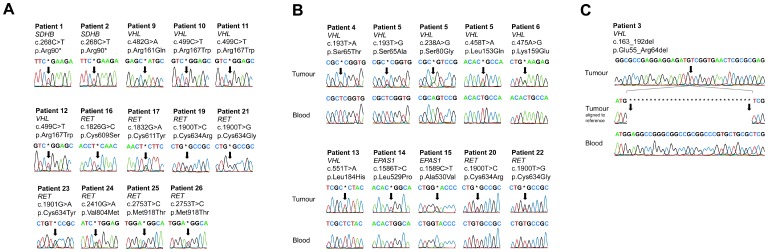
Chromatograms exported from CLC Genomics Workbench 5.5 displaying (A) Pathogenic genetic variants available in constitutional DNA, (B) confirmed somatic variants and (C) 30 base pair somatic deletion in VHL.